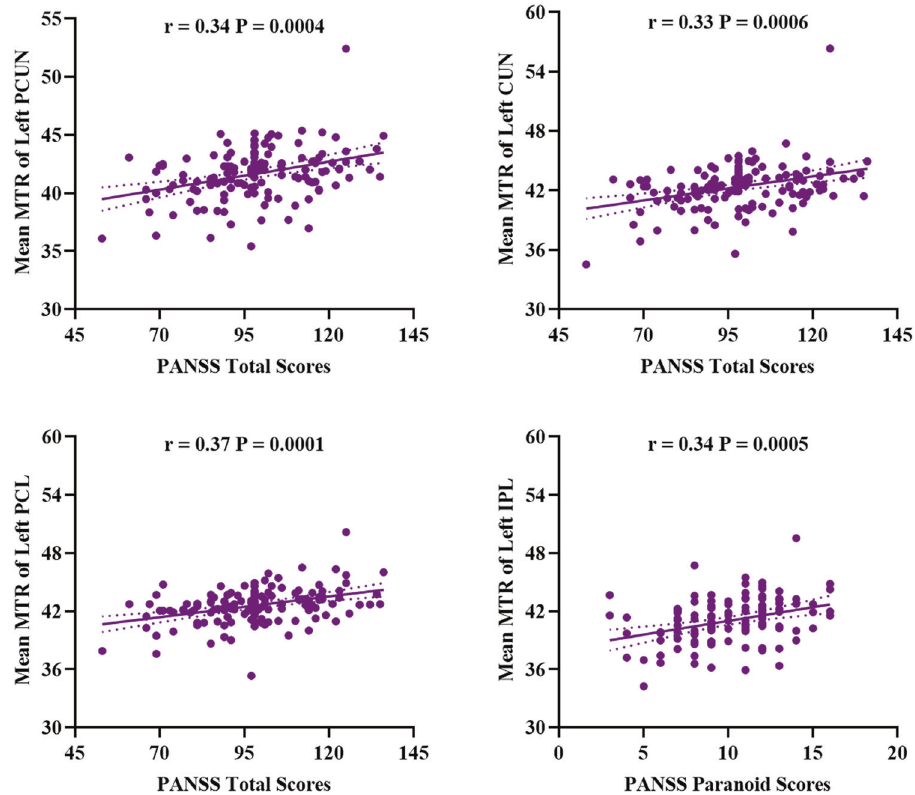
Fig. 2 Scatter plots showing the correlations between PANSS total scores and regional mean MTR in fi rst-episode schizophrenia. Partial correlations (presented as r ) were conducted between regional mean MTR and PANSS score, with age, sex, and education years as covariates. Findings were signi fi cant (presented as P ) after correction for multiple comparisons using the Bonferroni correction. MTR magnetization transfer ratio, PCUN precuneus, CUN cuneus, IPL inferior parietal lobule, PCL paracentral lobule, PANSS Positive and Negative Syndrome